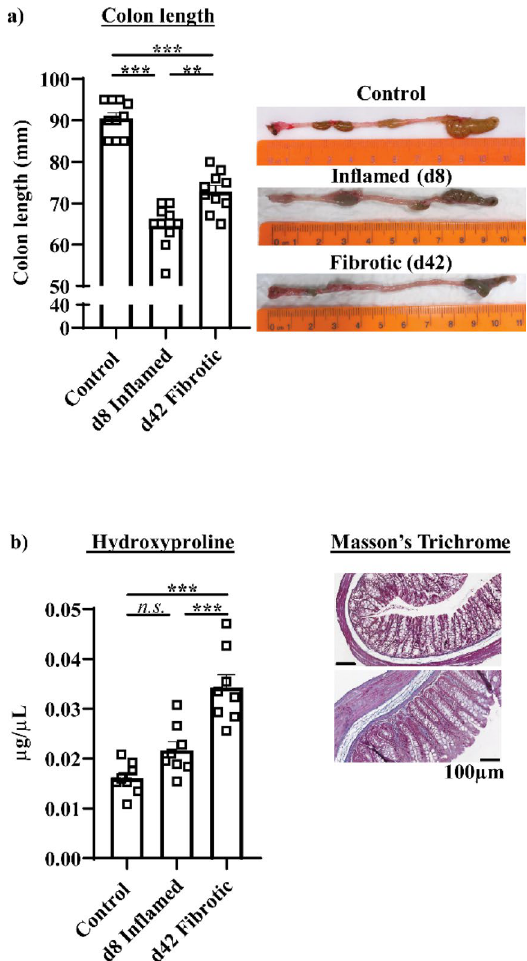
Figure 1. Colonic collagen content increases in inflamed (1 DSS cycle) and fibrotic (3 DSS cycles) mice. ( a ) Colon length did not shorten to the same extent in fibrotic mice as in inflamed mice. ( b ) Repeated DSS cycles increased the colonic collagen content as indicated by hydroxyproline concentration (left) and Masson’s trichrome staining (right) ** P < 0.01, *** P <